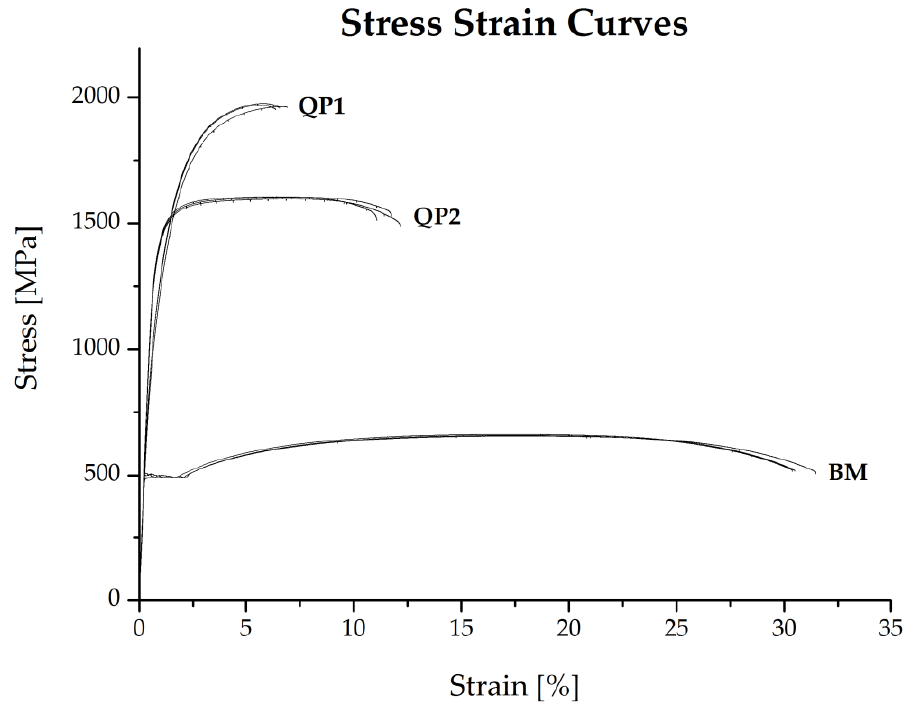
Figure 6. Stress–strain curves for the cold-rolled base material and the QP1 and QP2 condition. Figure 6. Stress – strain curves for the cold-rolled base material and the QP1 and QP2 condition. The diagram shows a good accordance for the three replicate samples of each